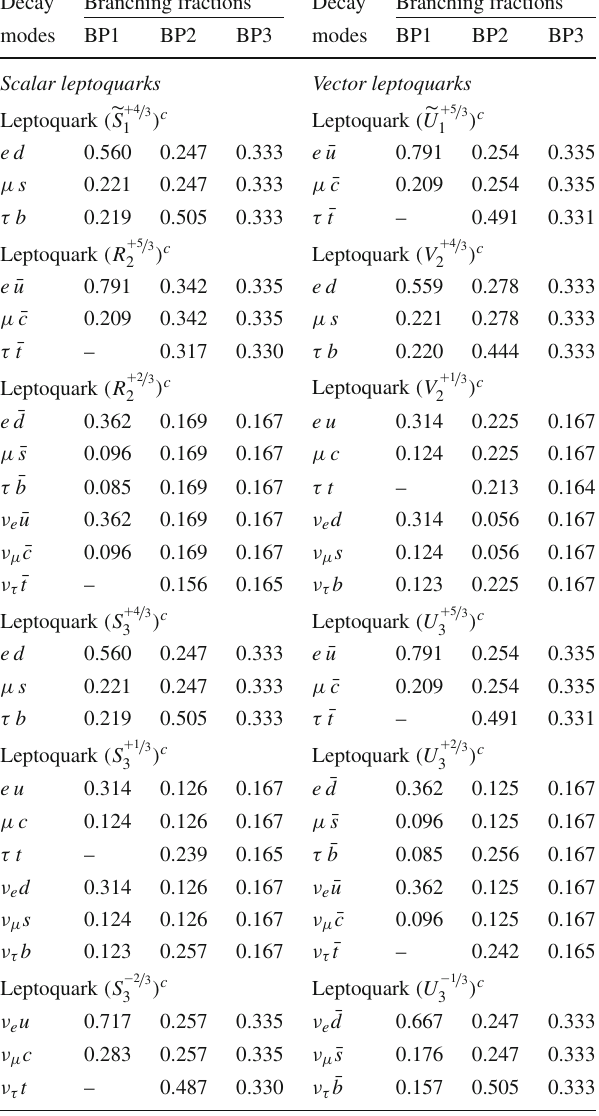
Table 3 Branching fractions of different leptoquarks for masses and couplings specified in Table 2. Branching fractions for BP4 scenario have not been displayed explicitly because they differ from BP3 case at third decimal places only Decay Branching fractions